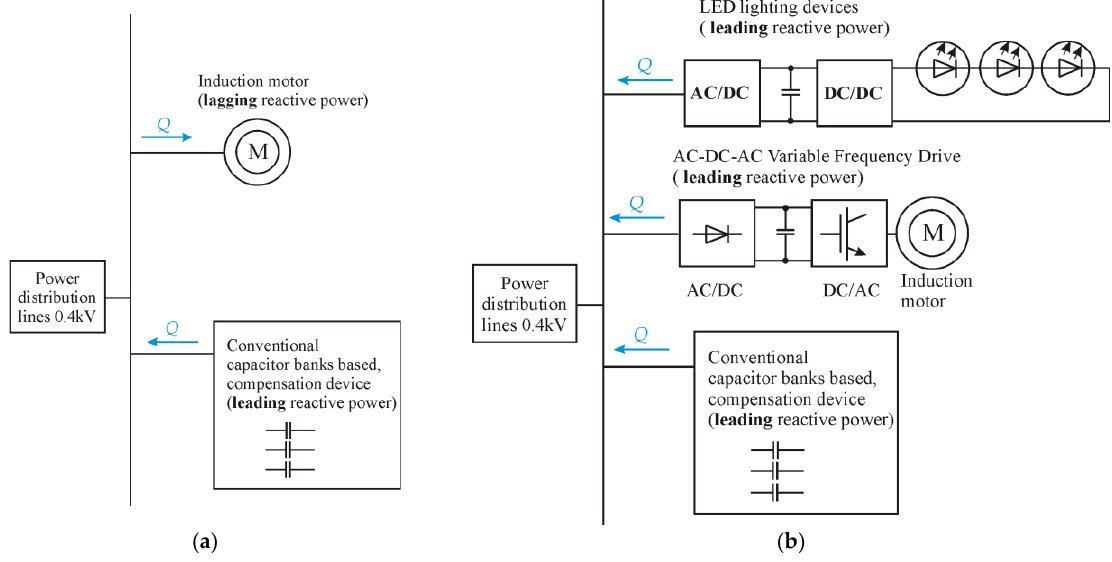
Figure 2. The loads and compensation device of the 0.4 kV power distribution lines: ( a ) Conventional load of power distribution lines; ( b ) Modern load of power distribution lines (causes over-compensation).